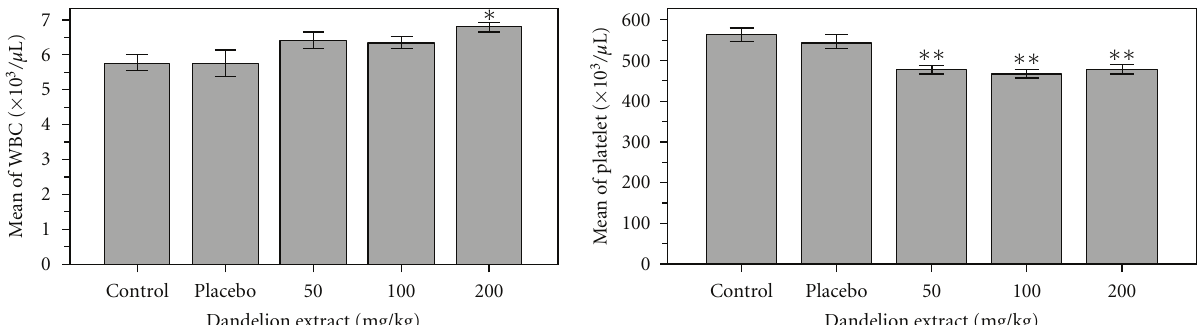
Figure 2: Comparison of mean platelet and mean number of white blood cells between experimental groups, control and placebo.